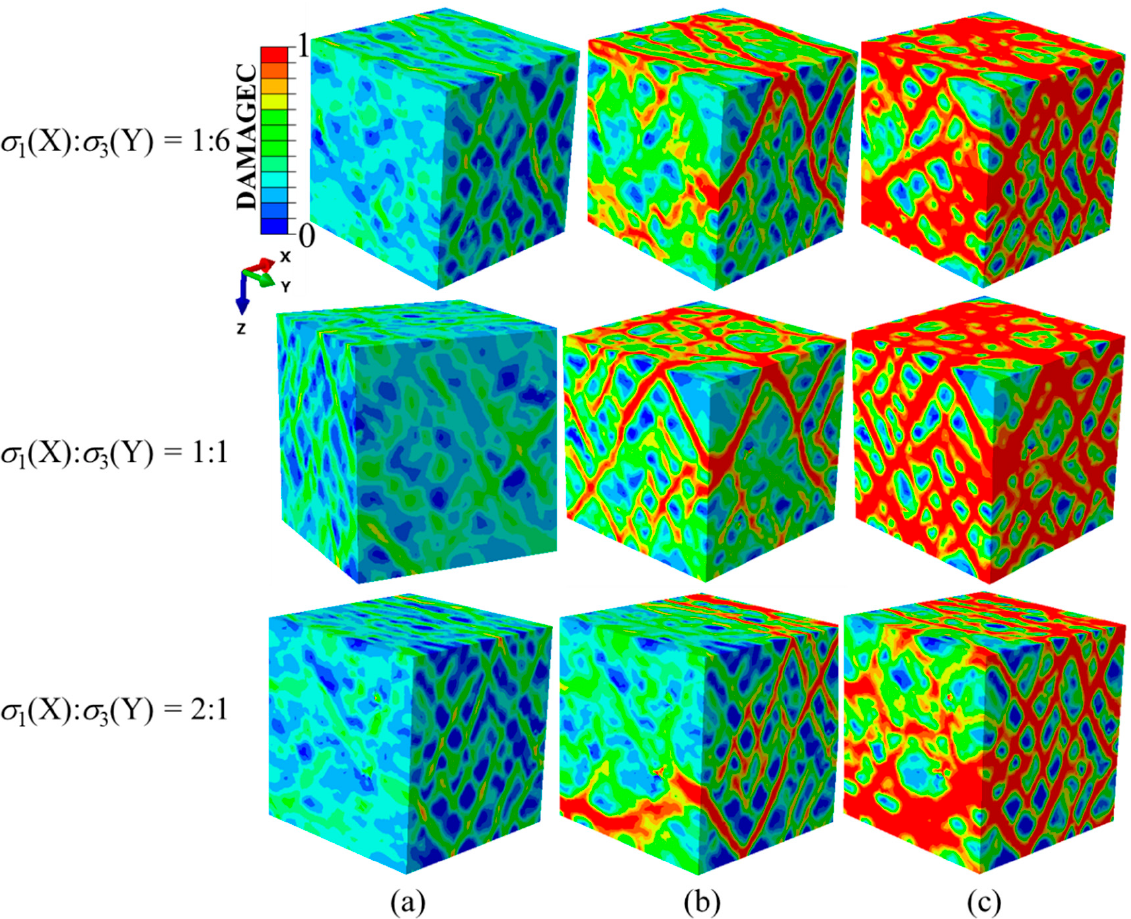
Figure 10. Damage evolution process and failure patterns with different σ 1 / σ 3 ratios when σ 3 (Y)/f c = − 0.25: ( a ) at peak stresses, ( b ) further damage evolution and ( c ) complete failure of the specimens. DAMAGEC denotes damage due to compression.